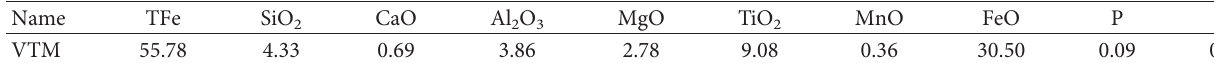
Table 2: Chemical composition of VTM concentrates for the experiments (wt%).